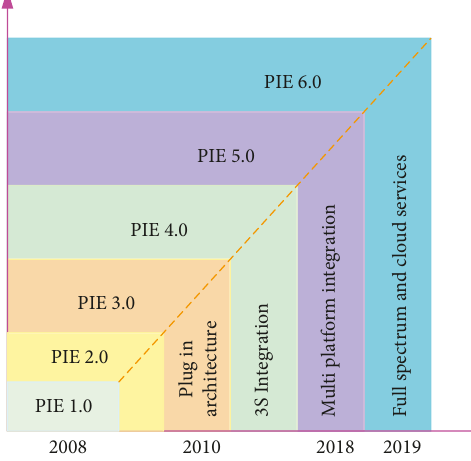
Figure 5: Schematic diagram of PIE development